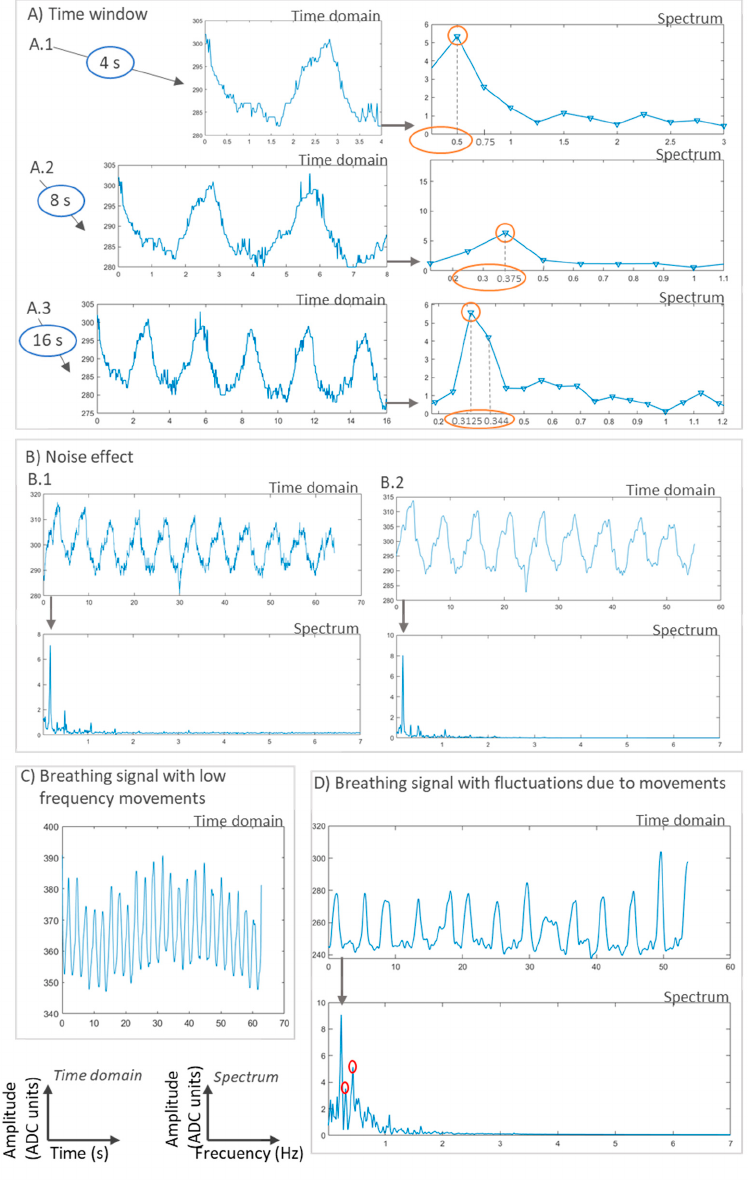
Figure 31. Frequency analysis of sample real respiratory signals obtained from a public dataset [254].